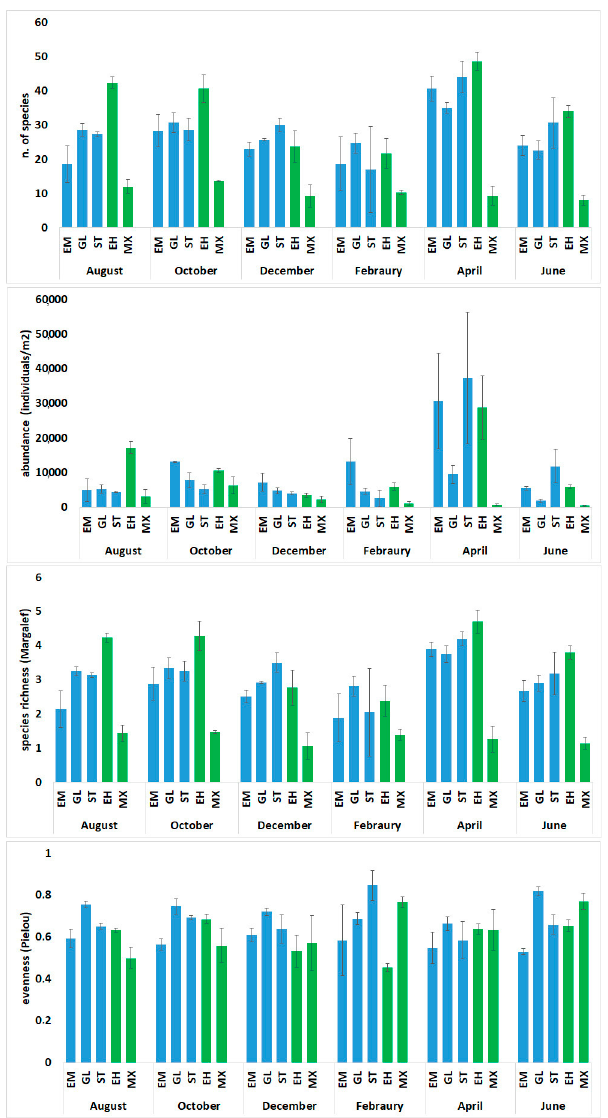
Figure 2. Average (±SE) number of species, abundance (individuals/m 2 ), species richness (Margalef), and evenness (Pielou) bimonthly analyzed at each sampling site. Green bars were sites exposed to water discharge (EH, MX); light blue bars were sites exposed to urbanization (EM, GL, ST).